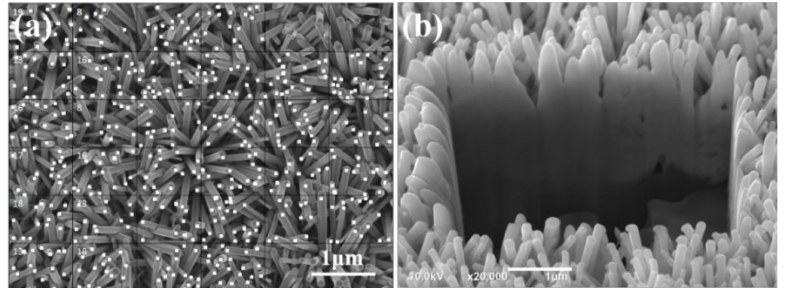
Figure 5. ( a ) Surface morphology used to estimate the density and ( b ) cross-sectional image used to estimate the length of ZnO